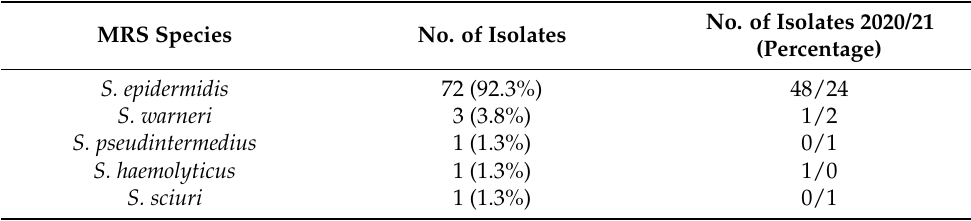
Table 2. Species identified, percentage and year of isolation.